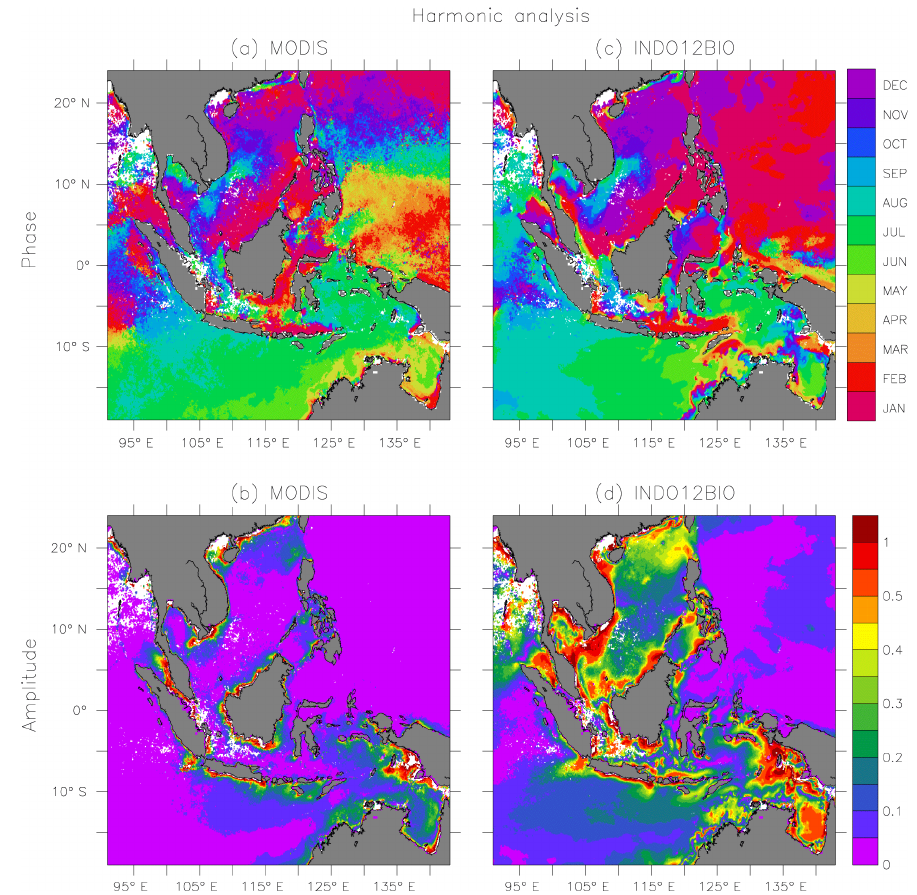
Figure 10. Timing of maximum chlorophyll a (a, c) and amplitude (b, d) for a monthly climatology of surface chlorophyll a concentrations between 2010 and 2014: MODIS case-1 (left) and INDO12BIO (right). The model was masked as a function of the